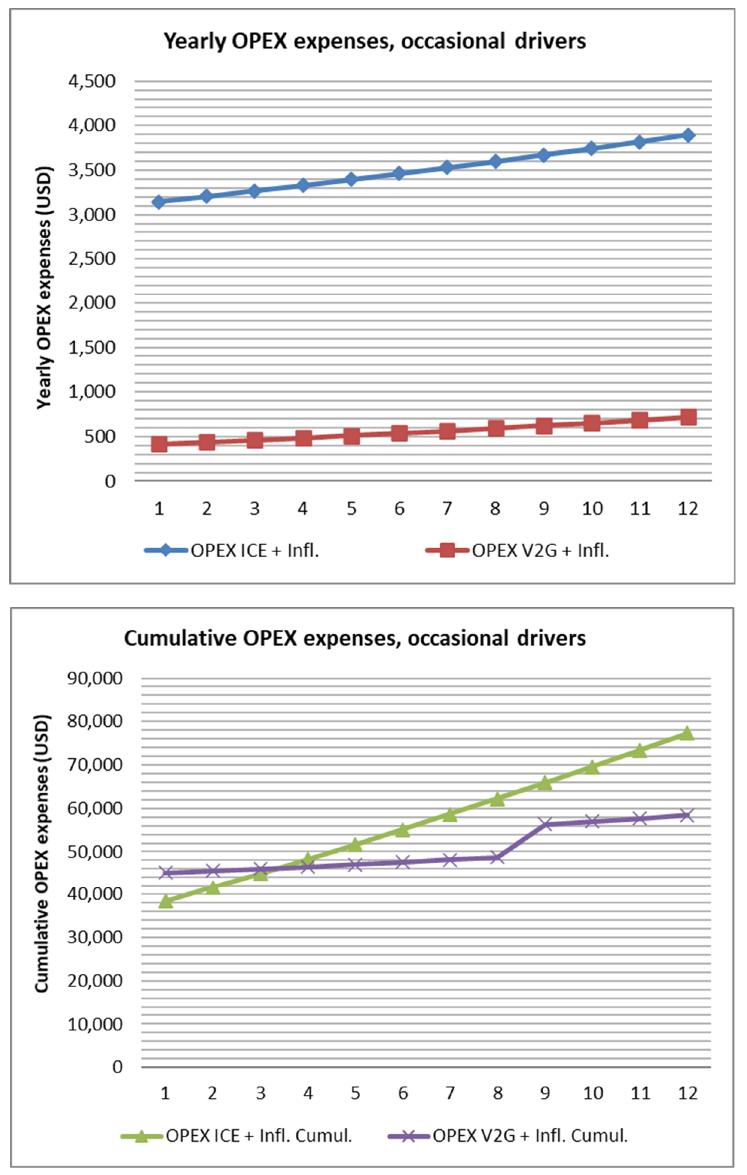
Figure 7. Yearly and cumulative OPEX expenses between an ICE vehicle and a V2G, frequent rivers.